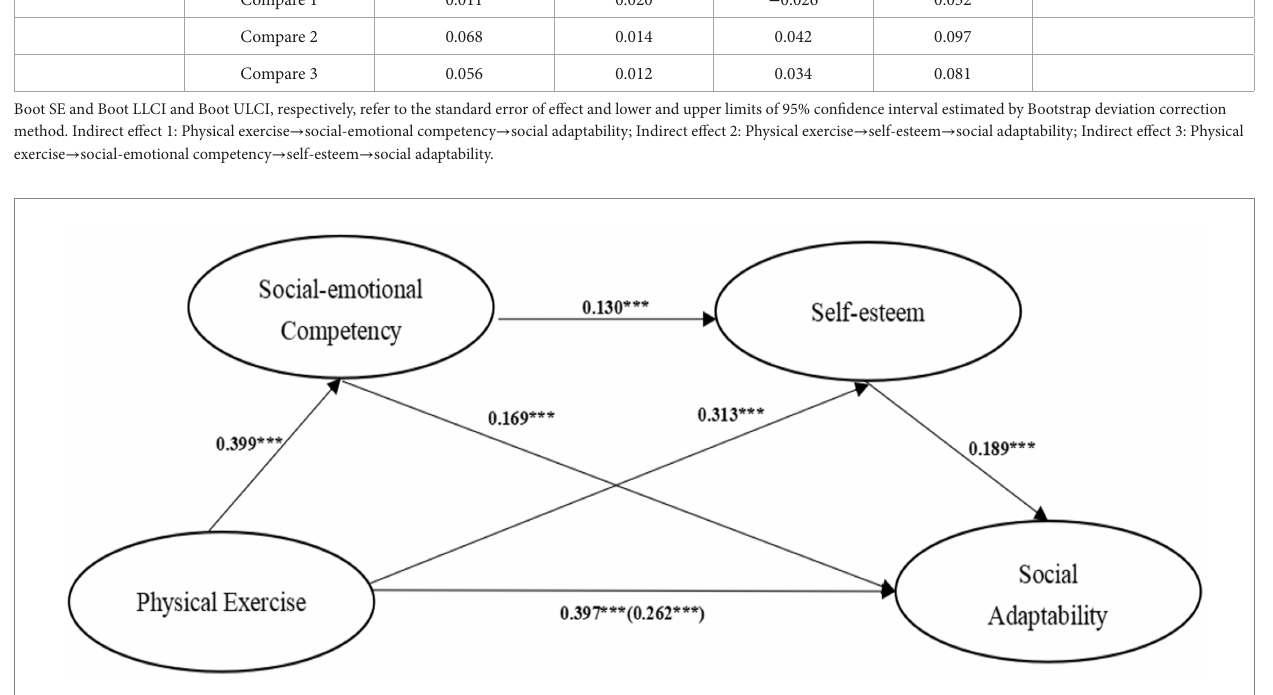
FIGURE 2 Chain mediation model of social-emotional competency and self-esteem between physical exercise and social adaptability (*** p <